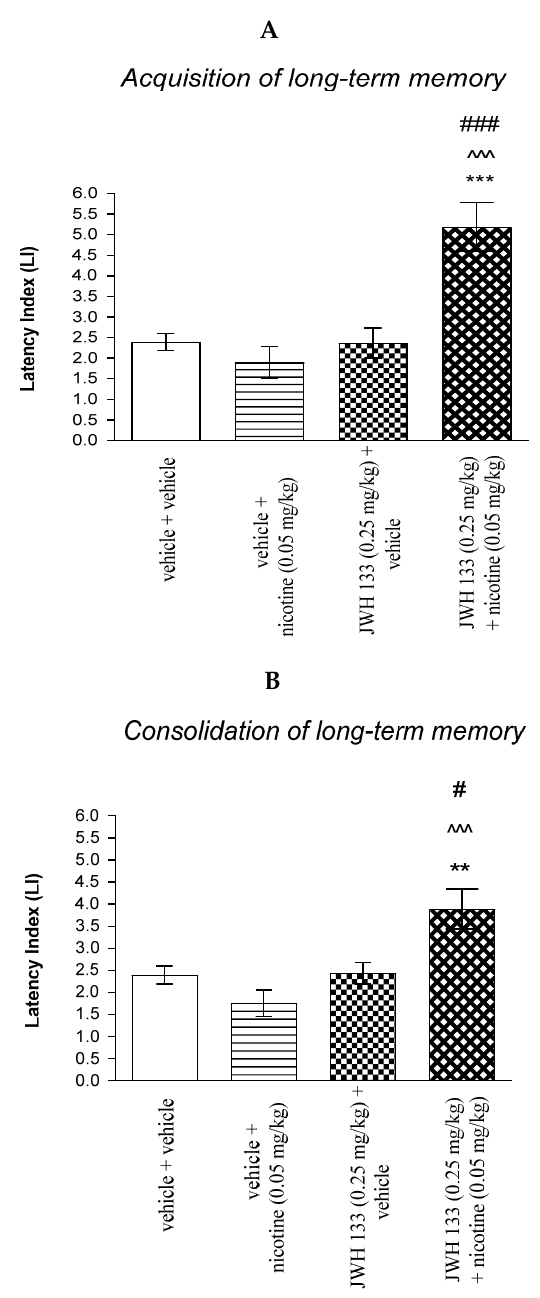
Figure 4. The influence of an acute co-administration of CB2 receptor agonist and non-effective dose of nicotine on the cognition-related responses expressed as latency index (LI) during the acquisition ( A ) and consolidation ( B ) memory using the PA test in mice. *** p < 0.001 vs. vehicle/vehicle-treated mice; ˆˆˆ p < 0.001 vs. vehicle/nicotine (0.05 mg/kg)-treated mice; ### p < 0.001 vs. JWH 133 (0.25 mg/kg)/vehicle-treated mice; ** p < 0.01 vs. vehicle/vehicle-treated mice; # p < 0.05 vs. JWH 133 (0.25 mg/kg)/vehicle-treated mice.